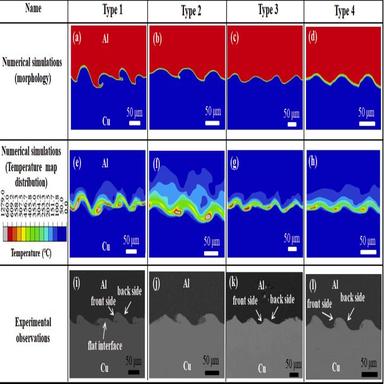
Various wave morphologies obtained from the numerical simulations (a-d), corresponding temperature distributions (e-h) and the experimental observations of the waves (i-l).